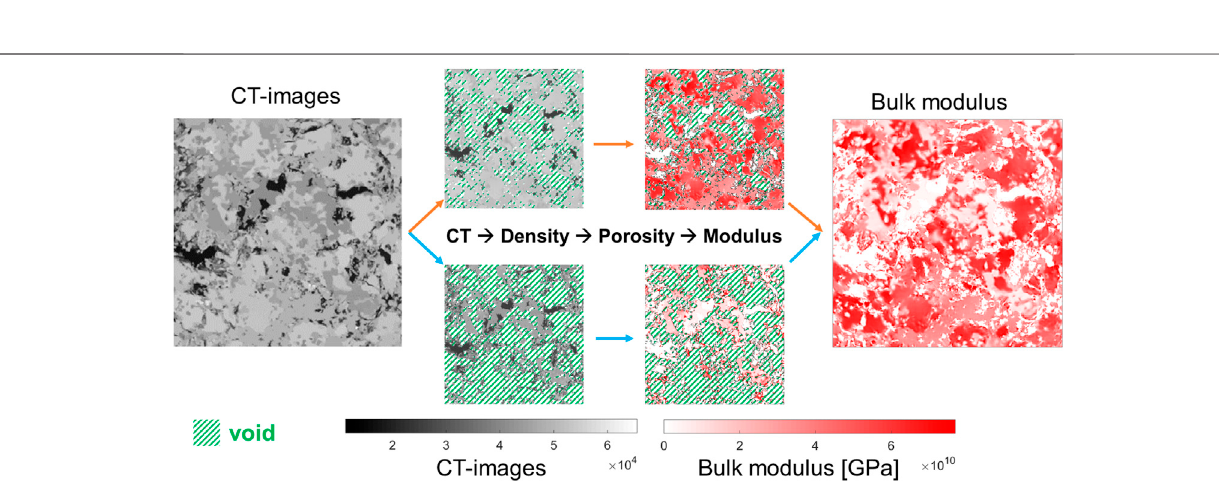
Frontiers in Earth Science |